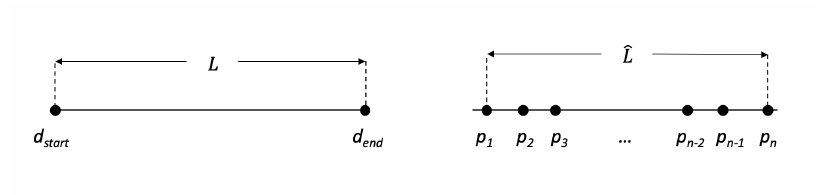
Figure 1. Hypothetical line ( left ) and real link with n map-matched GPS points ( right